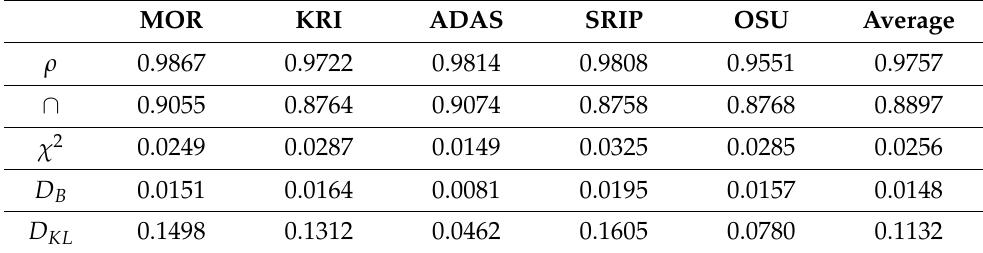
Table 2. Average scores of the measures in Figure 2. The scores of the correlation coefficient and histogram intersection are close to unity, and the scores of the Chi-squared test, Bhattacharyya distance, and Kullback–Leibler divergence are close to